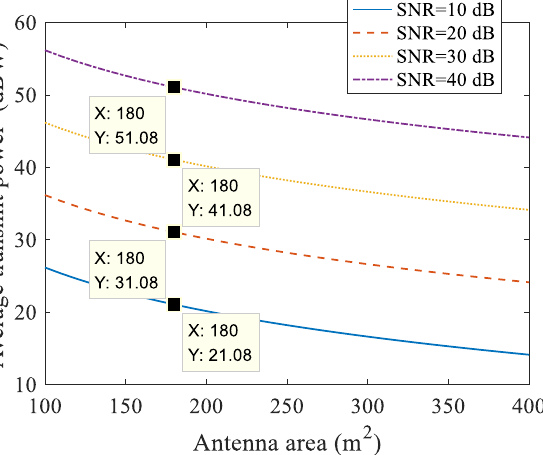
Figure 13. Required average transmit powers under various pairs of SNR and antenna area.